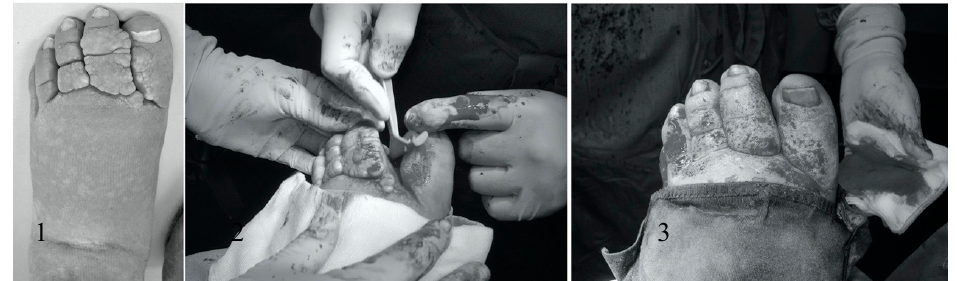
Figure 1. Procedure of shaving late-onset lymphedema left leg with razorblade: ( 1 ) preoperatively, ( 2 ) during procedure, and ( 3 ) end result postoperatively.